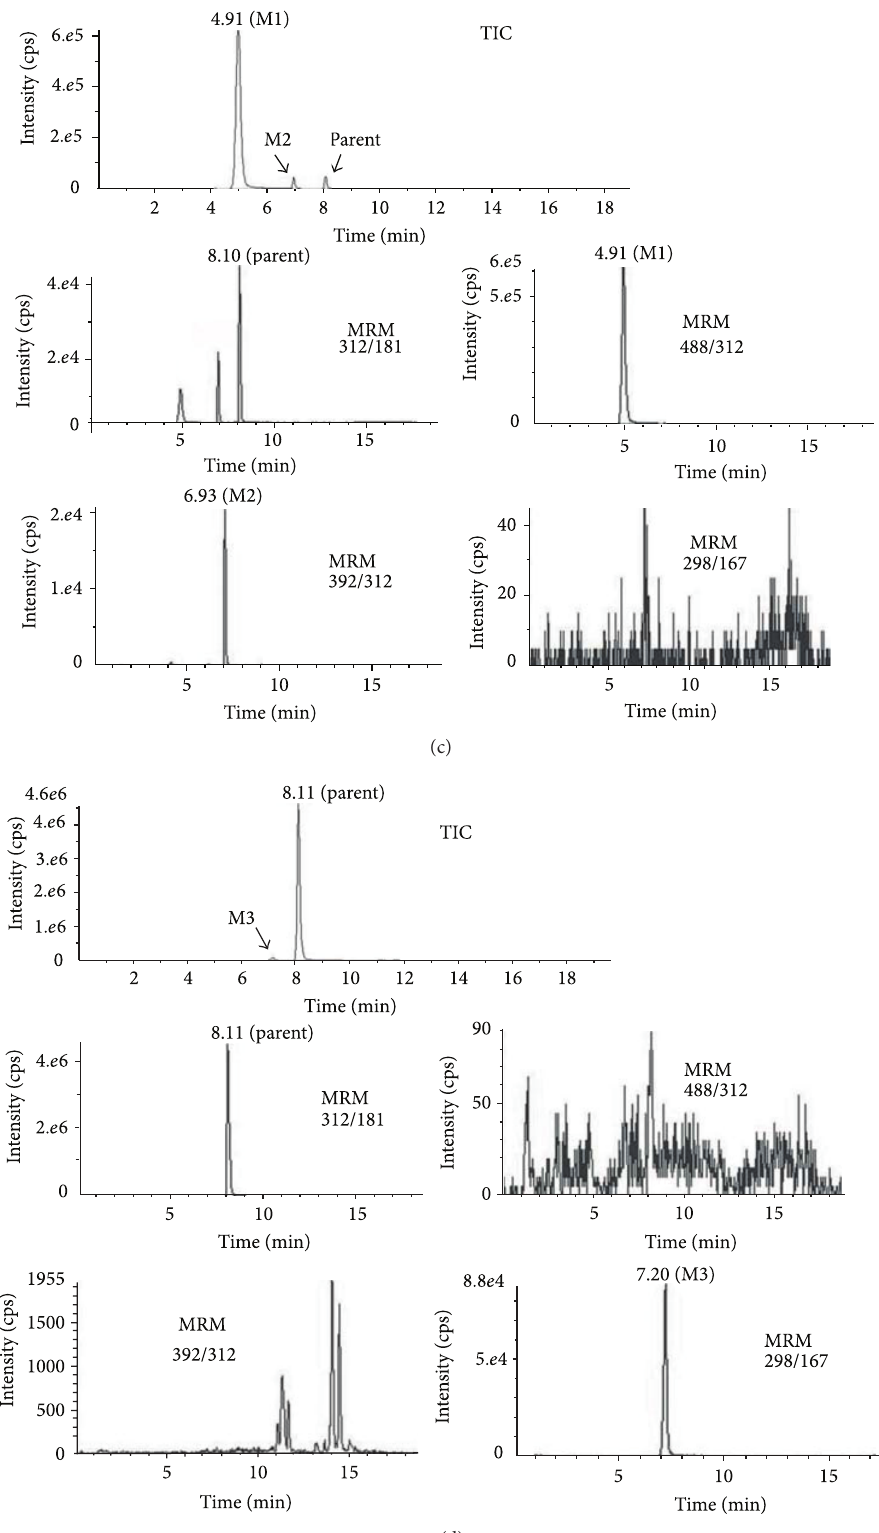
Figure 2: Representative extracted ion chromatograms for metabolites (M1–M3) in various biological samples after oral dosing of leonurine (30 mg/kg). TIC: total ion current chromatogram. (a) Bile samples; (b) urine samples; (c) plasma samples; (d) feces